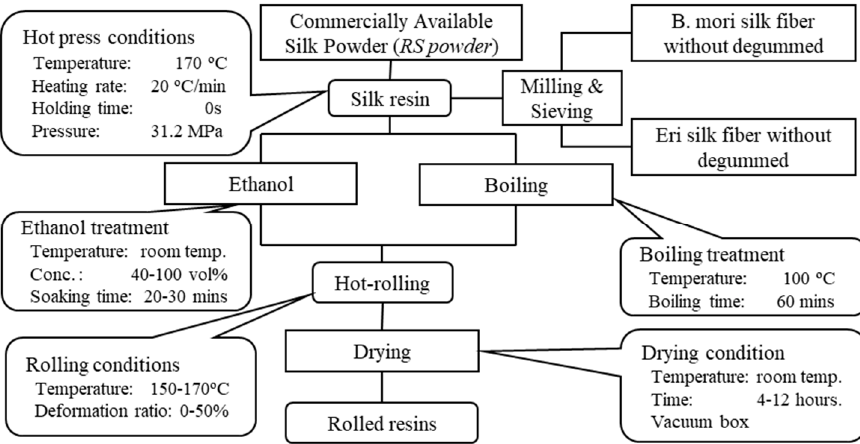
Figure 1. The flow diagram for preparing the hot-rolled silk resins.